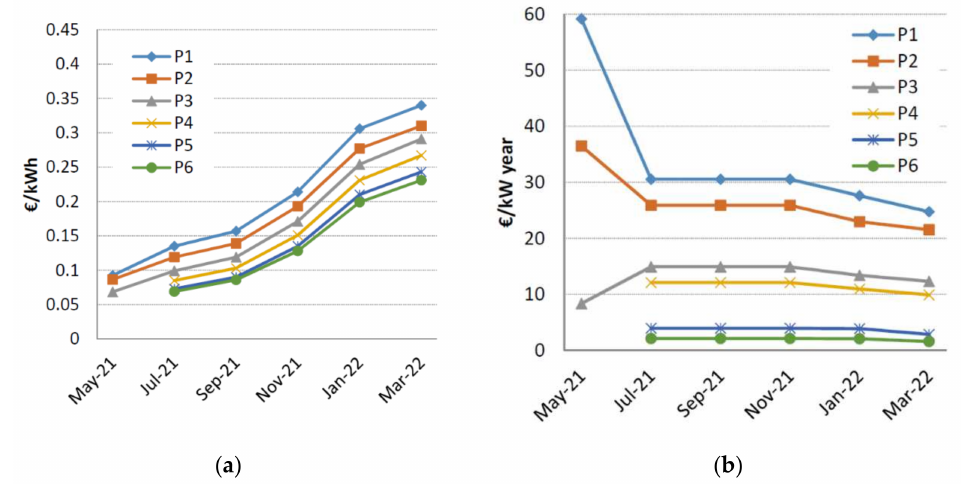
Figure 2. Evolution of the price of electricity offered to the consumer ( a ) energy term: € /kWh; ( b ) power term: € /kW